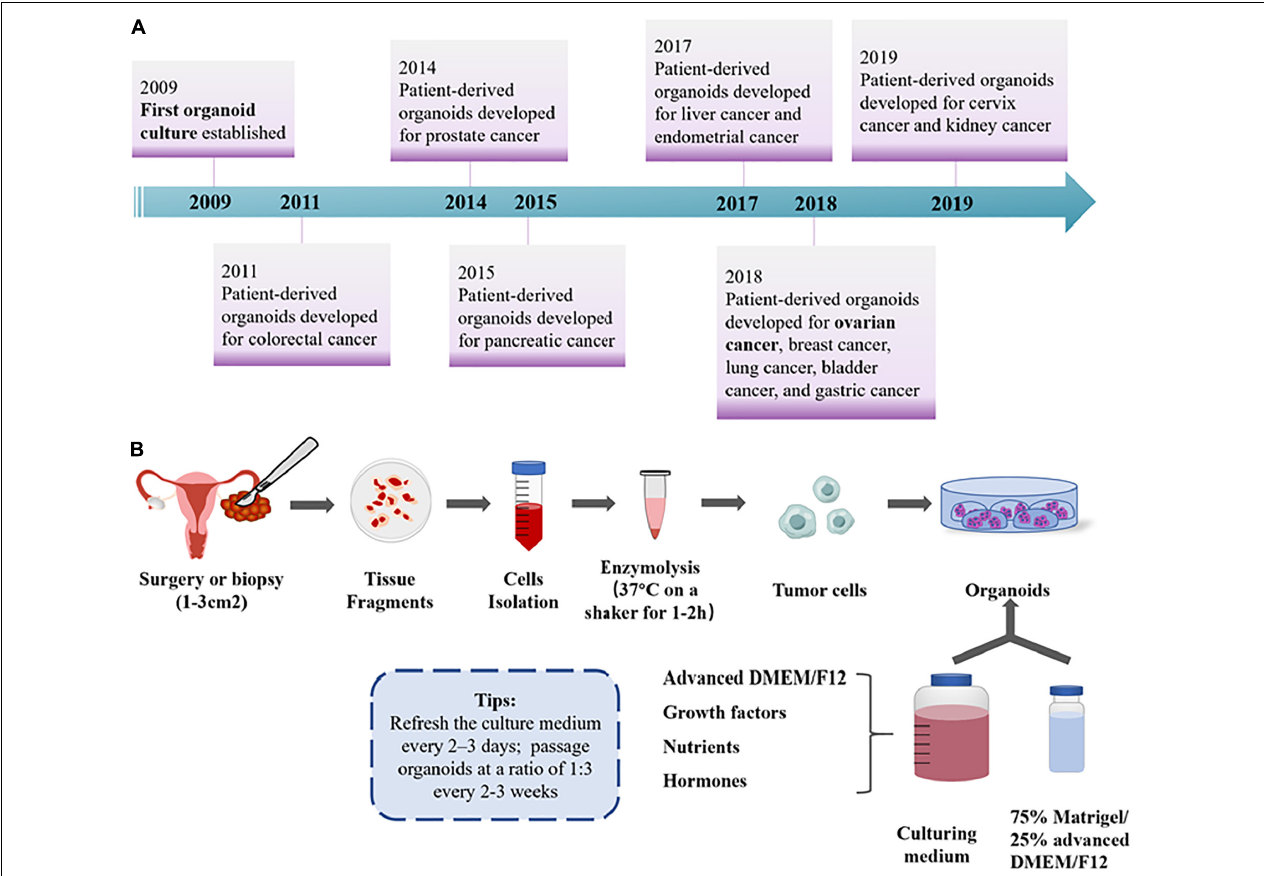
FIGURE 2 | General overview for OC organoids. (A) Timeline for patient-derived organoid development until now. (B) The workflow of OC organoid culture development. Formation of organoids was initiated by mechanical and enzymatic digestion of primary tumor tissue, followed by seeding cells into the fundamental ECM and culturing medium with various growth factors for long-term maintenance (Hill et al., 2018; Kopper et al.,